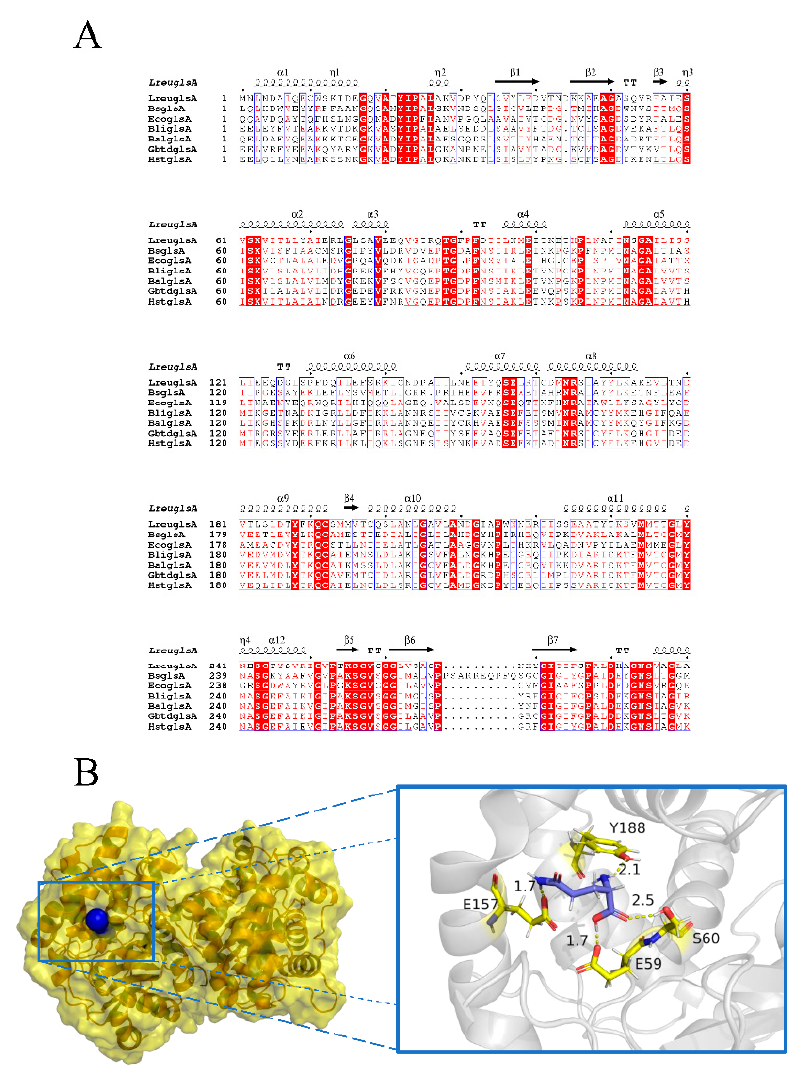
Figure 3. Structural prediction and identification of the active center. ( A ) Analysis of conserved residues required for enzyme function by a sequence alignment of known L-glutaminases. The color scheme option was normal in ESPript 3 (http://espript.ibcp.fr (accessed on 3 May 2022)). ( B ) The PDB structure generated by AlphaFold2-Multimer and molecular docking via Schrödinger. The images were generated using PyMOL. The blue part is the substrate entry and exit